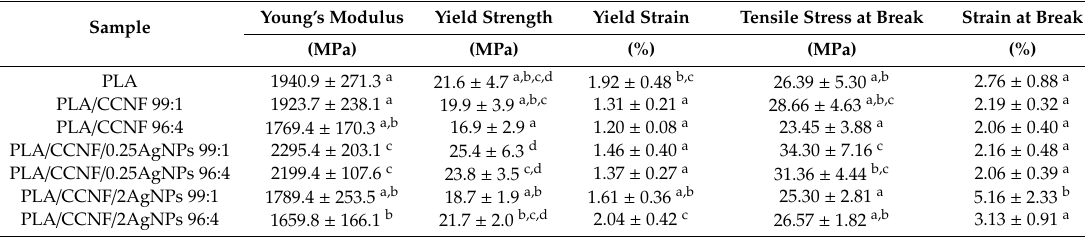
Tensile properties of films obtained for neat PLA and PLA reinforced with CCNF, CCNF / 0.25AgNPs, and CCNF / 2AgNPs. Di ff erent superscript letters (a,b,c,d) in each column